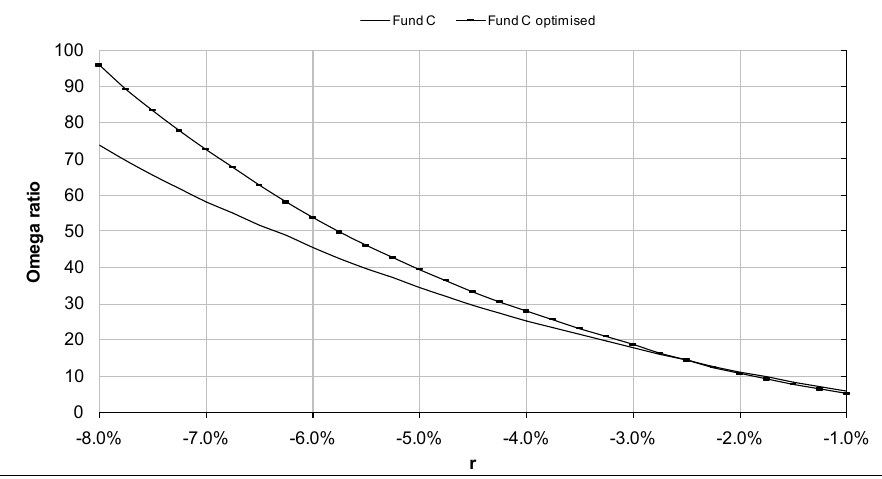
FIGURE 4: Fund C’s optimised Omega results Source: Compiled by